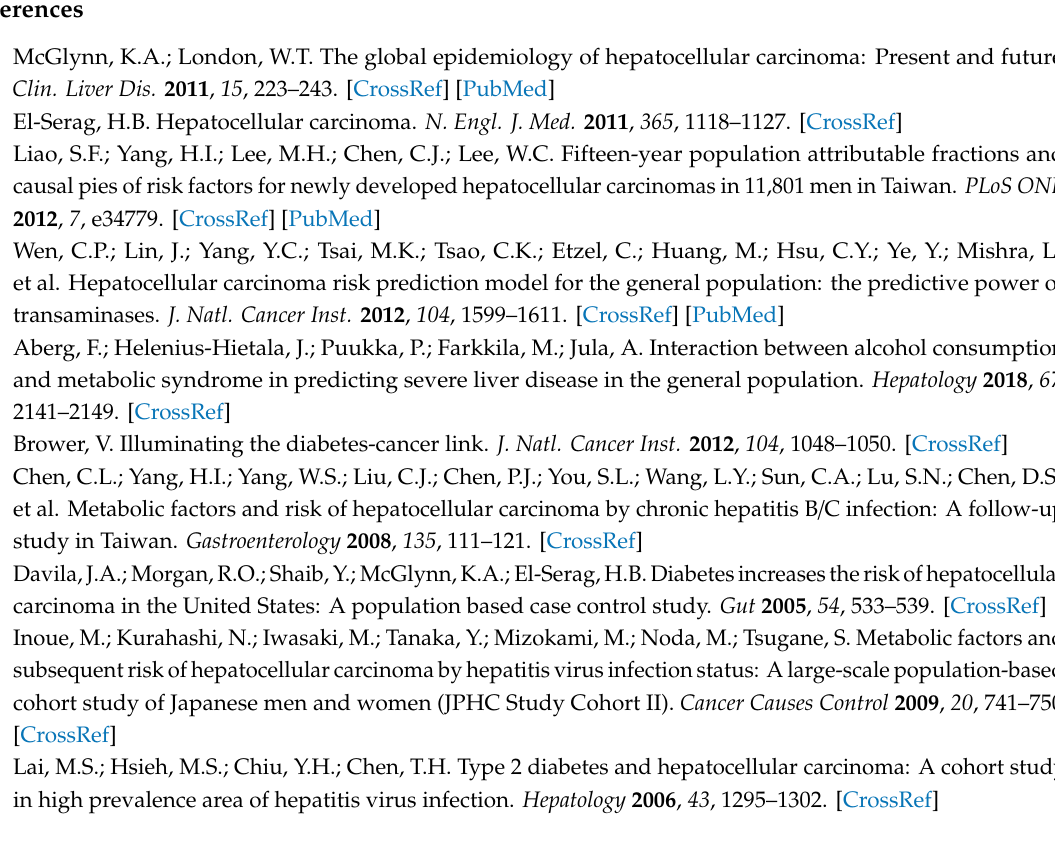
Figure S1: Study flowchart from 2004 to 2013 before and after exclusion of patients with chronic viral hepatitis; Table S1: Hepatocellular carcinoma cases and matched controls among newly diagnosed type 2 diabetes patients prescribed any antidiabetic agents (from 2003 to 2013); Table S2: Hepatocellular carcinoma cases and matched controls among newly diagnosed type 2 diabetes patients prescribed any antidiabetic agents (from 2004 to 2013); Table S3: Hepatocellular carcinoma cases and matched controls among newly diagnosed type 2 diabetes patients without chronic viral hepatitis prescribed any antidiabetic agents (from 2004 to 2013); Table S4: Risk of hepatocellular carcinoma associated with all insulin analogues among newly diagnosed type 2 diabetes patients prescribed any antidiabetic agents before and after exclusion of patients with chronic viral hepatitis; Table S5: Risk of hepatocellular carcinoma associated with insulin glargine or detemir among newly diagnosed type 2 diabetes patients prescribed any antidiabetic agents before and after exclusion of patients with chronic viral hepatitis (from 2004 to 2013); Table S6: Interaction between insulin glargine or detemir and chronic viral hepatitis on risk of hepatocellular carcinoma among newly diagnosed type 2 diabetes patients prescribed any antidiabetic